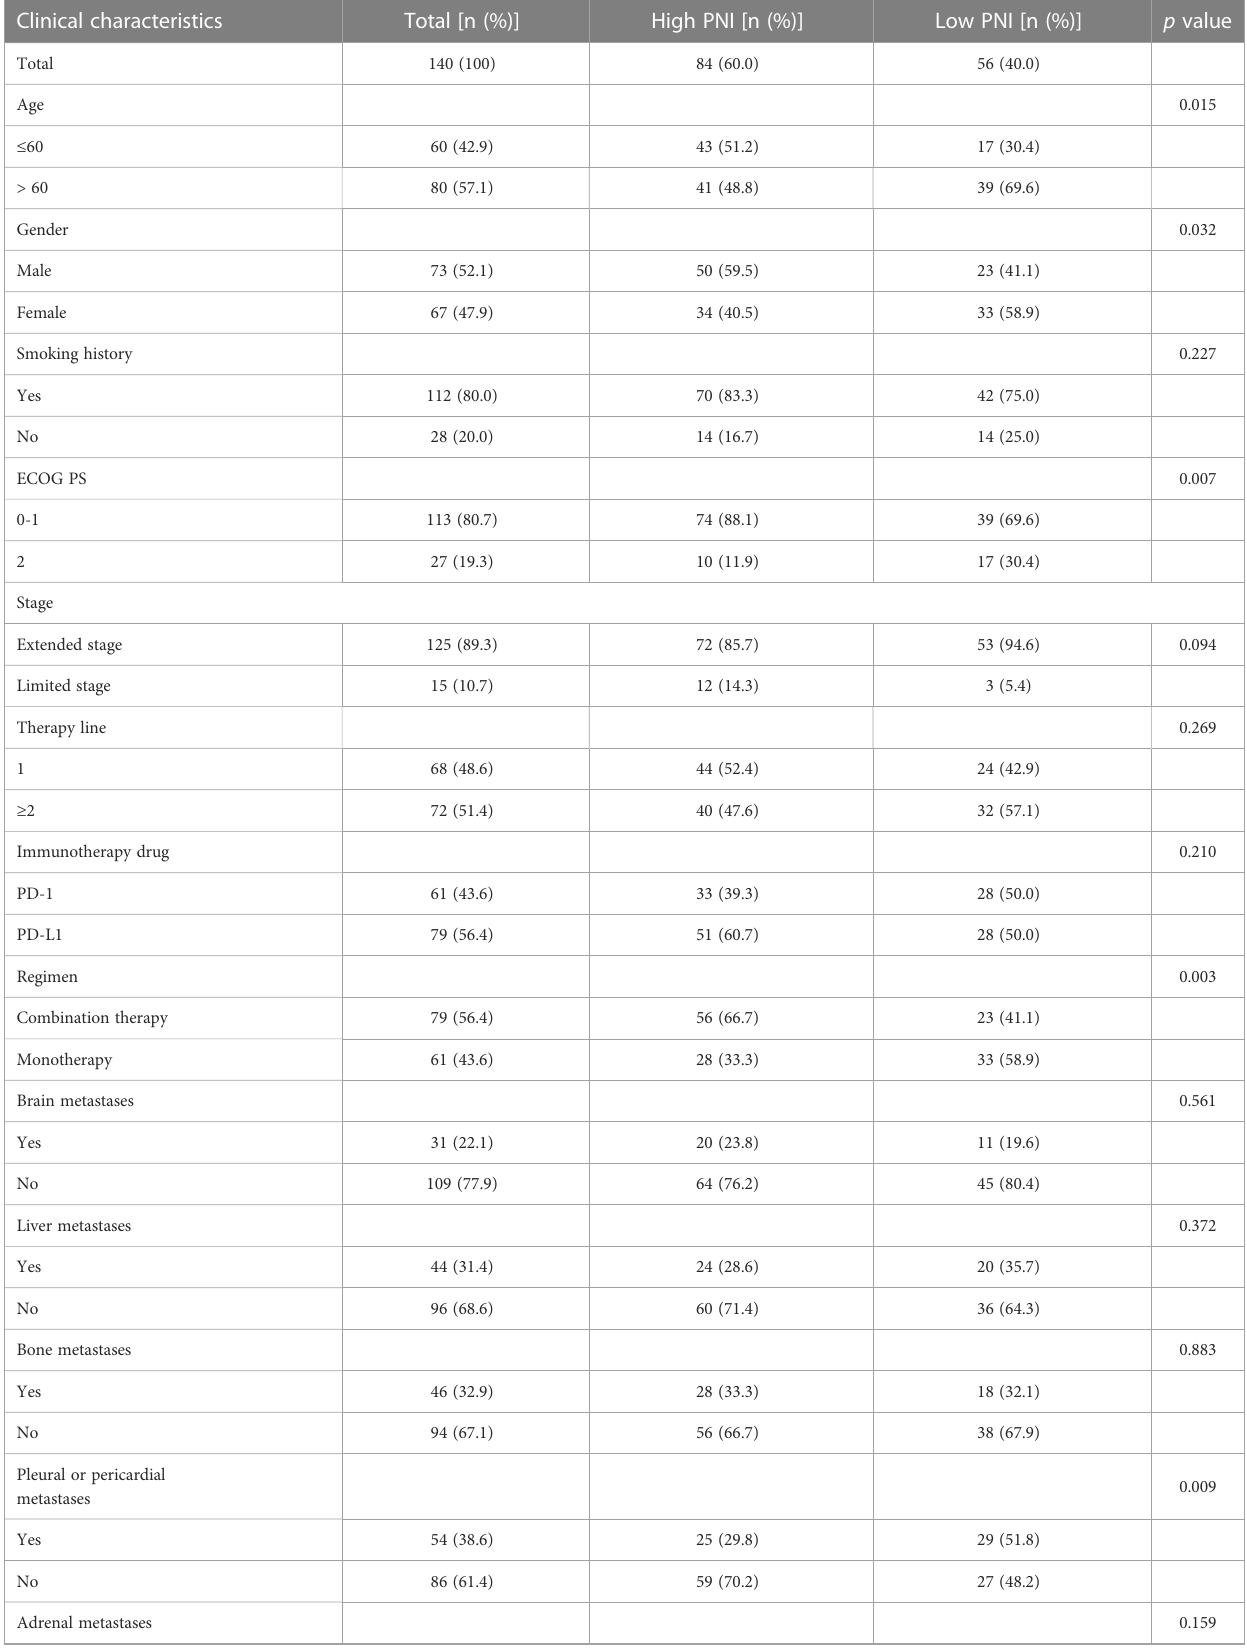
TABLE 1 Clinical characteristics of the 140 patients received PD-L1/PD-1 inhibitors treatment. Clinical